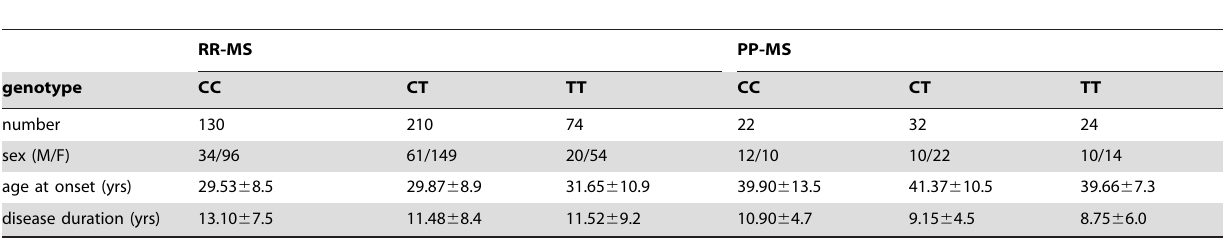
Table 4. Characteristics of MS subjects (discovery dataset) according to SNP rs4880213.